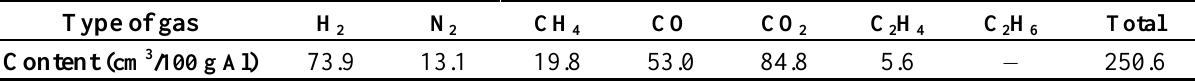
Table 1. Amounts and types of gases in used ADC12 Al alloy die-casting plates. Type of